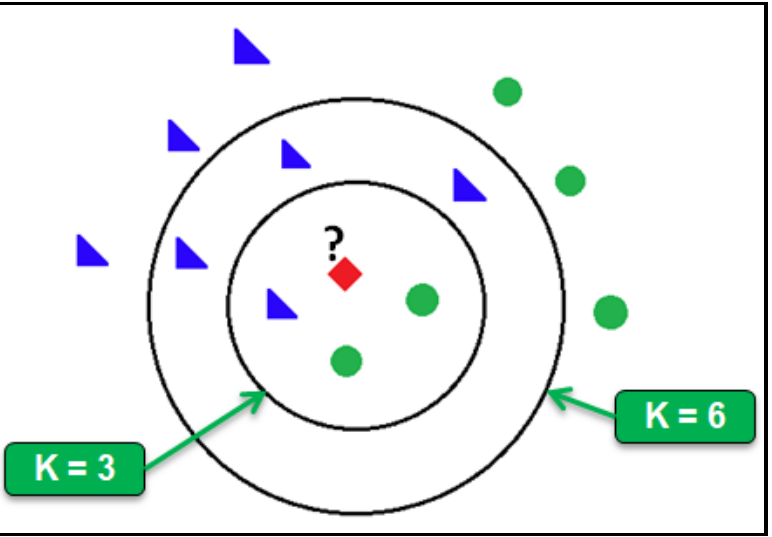
Figure 5. KNN explanation with k = 3 and k = 6 neighbors (blue, green, and red show distribution of class of data).